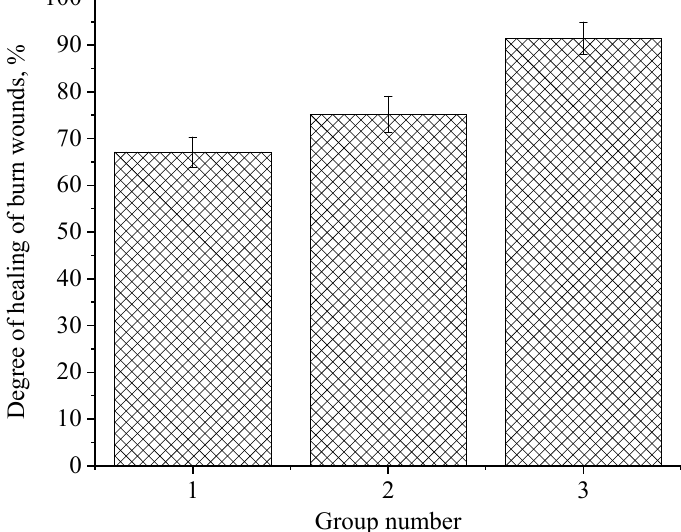
Figure 12. The degree of healing of burn wounds in experimental animals: 1—hydroxyethylcellulose gel; 2—gel of ZnO MPs and hydroxyethylcellulose; 3—gel of ZnO NPs modified with hydroxyethylcellulose ( p = 0.05).